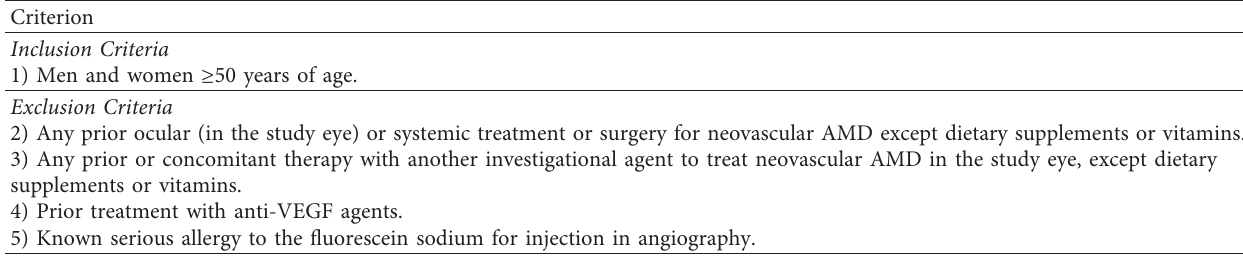
Table 3: Eligibility criteria of the VEGF Trap-Eye: Investigation of Efficacy and Safety in Wet AMD studies used for result analysis (category 3) and the number of eyes that did not meet the inclusion criteria or that met the exclusion criteria. Characteristic Inclusion